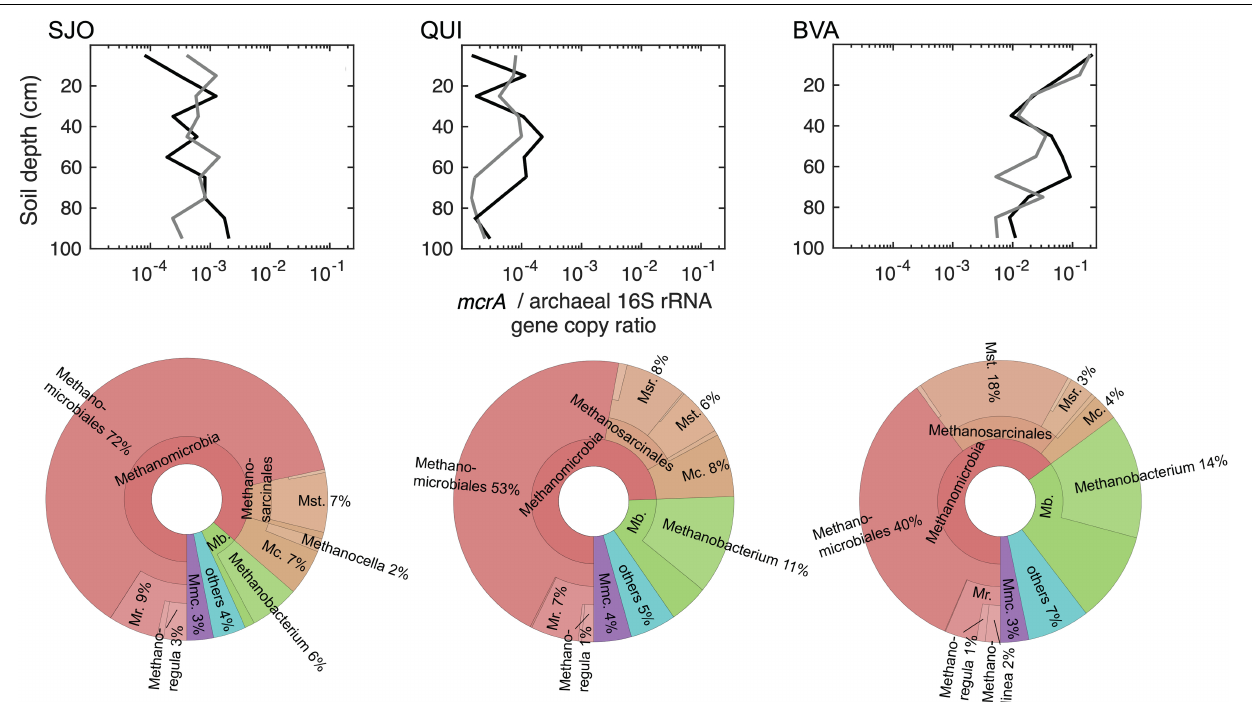
FIGURE 4 | McrA /archaeal 16S rRNA gene copy ratios along soil depth (left) and mcrA phylogeneticphylogenetic distribution of cumulative reads at all levels (right) in each peatland. Gene copy ratios are based on qPCR analysis and data from both soil cores are shown (dark and light gray lines). The gene ratios were used to better illustrate methanogen proportions relative to the total number of archaea, which explicitly revealed differences between peatlands. Absolute gene quantities ranged from 1.3 × 10 4 (SJO) to 1.8 × 10 9 (BVA) mcrA gene copies per g of dry soil and 8.7 × 10 5 (SJO) to 7.3 × 10 11 (QUI) archaeal 16S rRNA gene copies per g of dry soil. Relative abundance percentages refer to the total number of OTUs recovered at each site. Higher level taxa were collapsed if these were comprised of 100% the lower-level taxa. Mr., Methanoregulaceae ; Mst., Methanosaetaceae ; Msr., Methanosarcinaceae; Mc., Methanocellaceae; Mb., Methanobacteriaceae; Mmc., Methanomassiliicoccaceae .